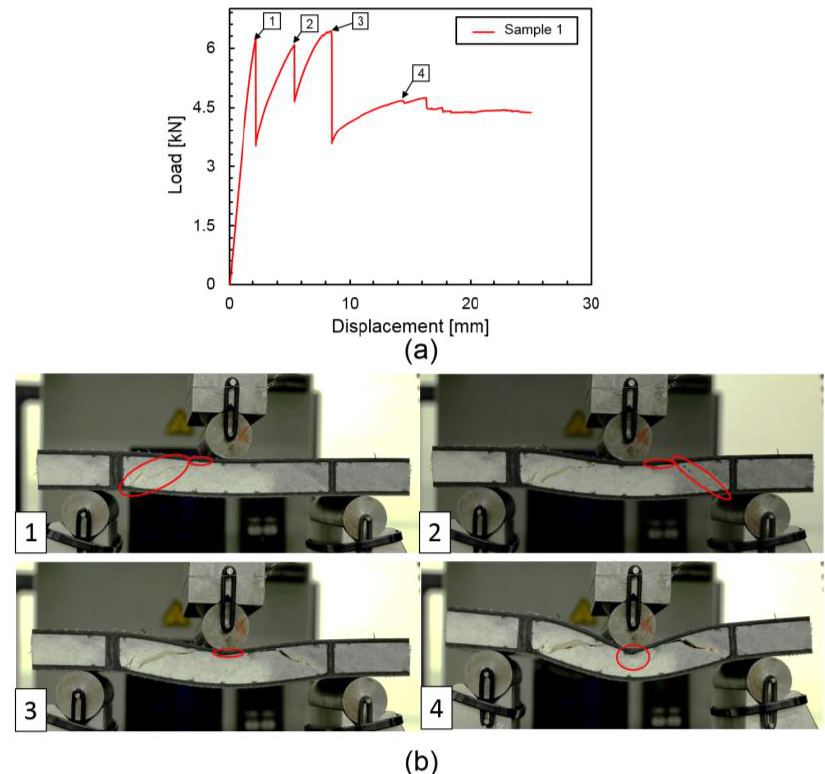
Figure 7. ( a ) Experimental load–displacement curve and ( b ) images of failure development for sample with ‘Configuration 3’. The red ellipses highlight the various types of damage indicated in the text.